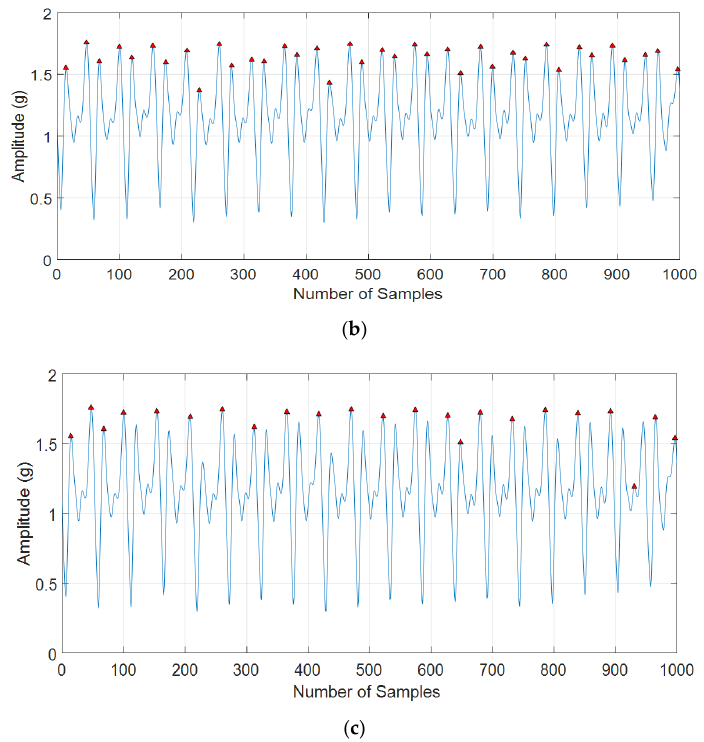
Figure 4. The d value on the peak detection in our normal walking data: ( a ) d = 5; ( b ) d = 14; ( c ) d = 20. The minimal peak prominence is either a signal valley or one of the signal endpoints in a window.